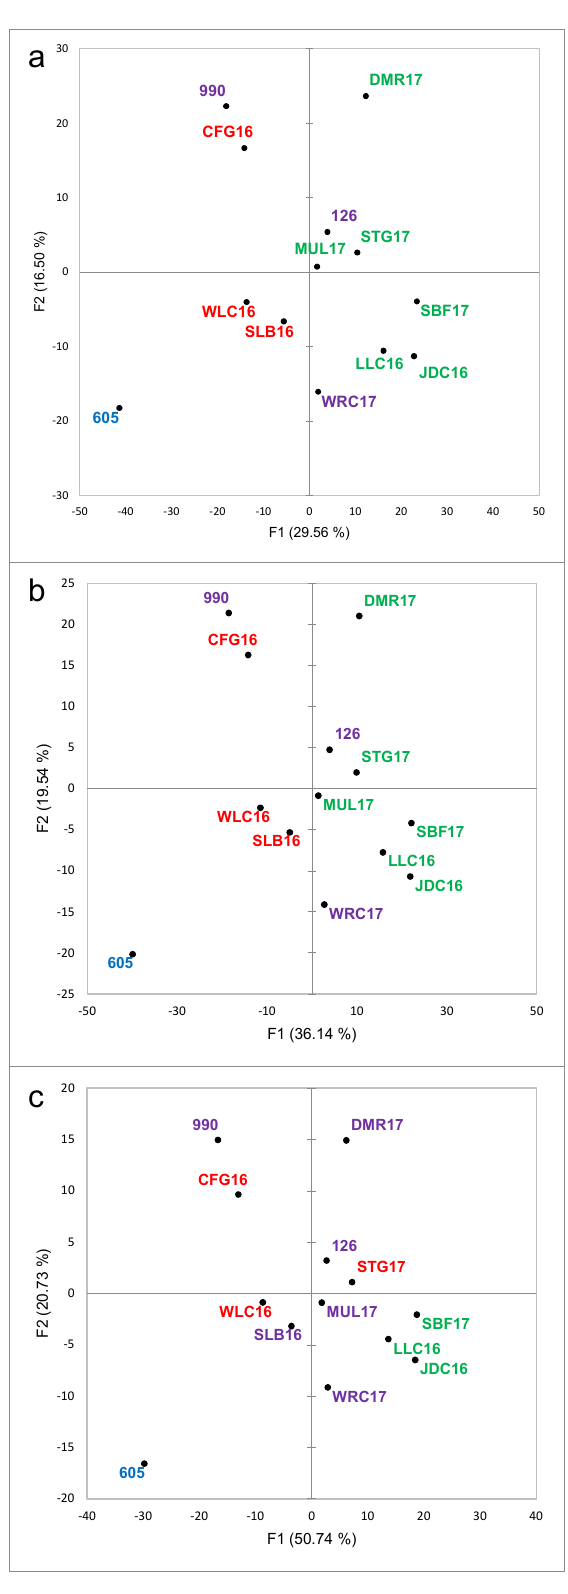
Figure 10. Principal Component Analysis score plot for Chenin Blanc wines based on the results of the LC-HRMS analysis in positive and negative mode. Wine codes as indicated in the text. Groupings in the score plots are color-coded according to the Hierarchical Cluster Analysis on the same data. ( a ). Raw data; ( b ). First variable selection; ( c ). Second variable selection. Variable selection as described in the text.